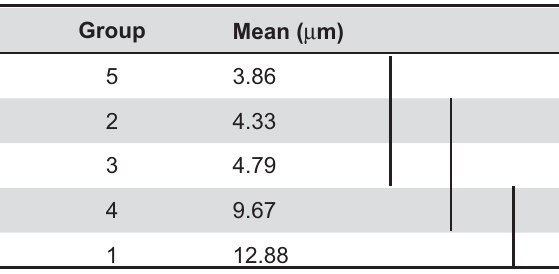
Table 2- Tukey test for comparisons of groups before fatigue test Group